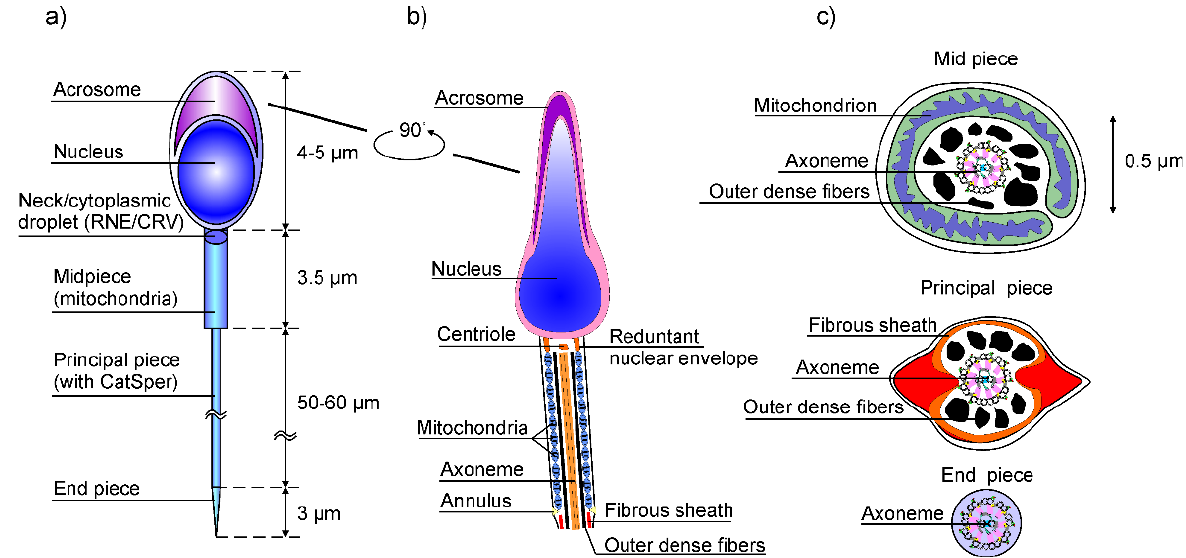
Figure 3. ( a ) Graphical illustration of the human sperm cell with its segmentation, indicating the spatial dimensions; ( b ) the cell head and mid-piece, with some details; and ( c ) the cross-sections of the mid-piece, principal-piece, and end-piece.